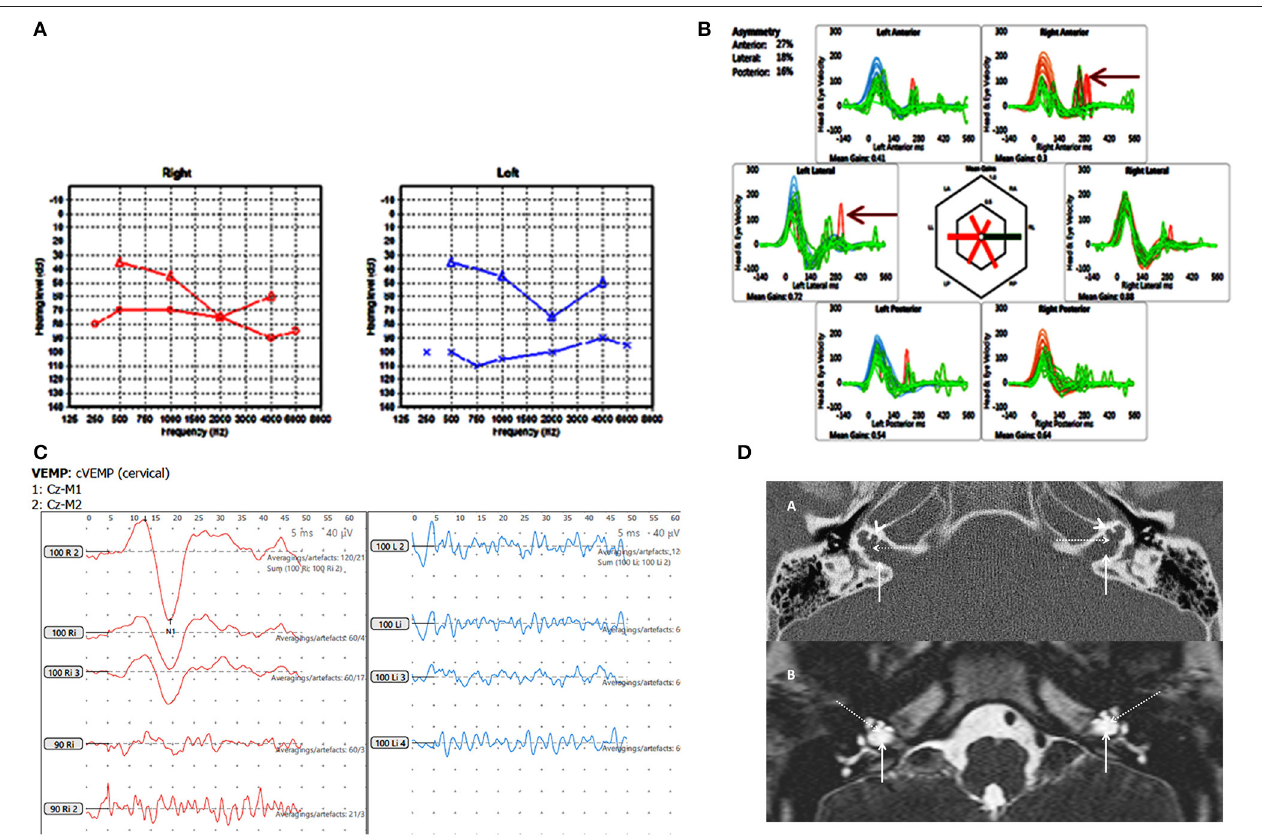
FIGURE 3 | Case number 6, X linked gusher. (A) , Pure tone audiometry showing significant bilateral mixed hearing loss. (B) , Catch up saccades on both sides on the vHIT (arrow). (C) , Absent cVEMP response on the side of the greater hearing loss and normal amplitude and threshold on the other side. (D) , Axial CT scan (A) and T2 DRIVE MRI image (B) of the petrous temporal bone demonstrating bilateral bulbous dilatation involving the fundus of the internal auditory canal (arrow) and bilateral incomplete separation of the basal turn of the cochlea (arrow head) from the fundus of the internal acoustic canal (dotted arrow) classical of X linked gusher disorder.